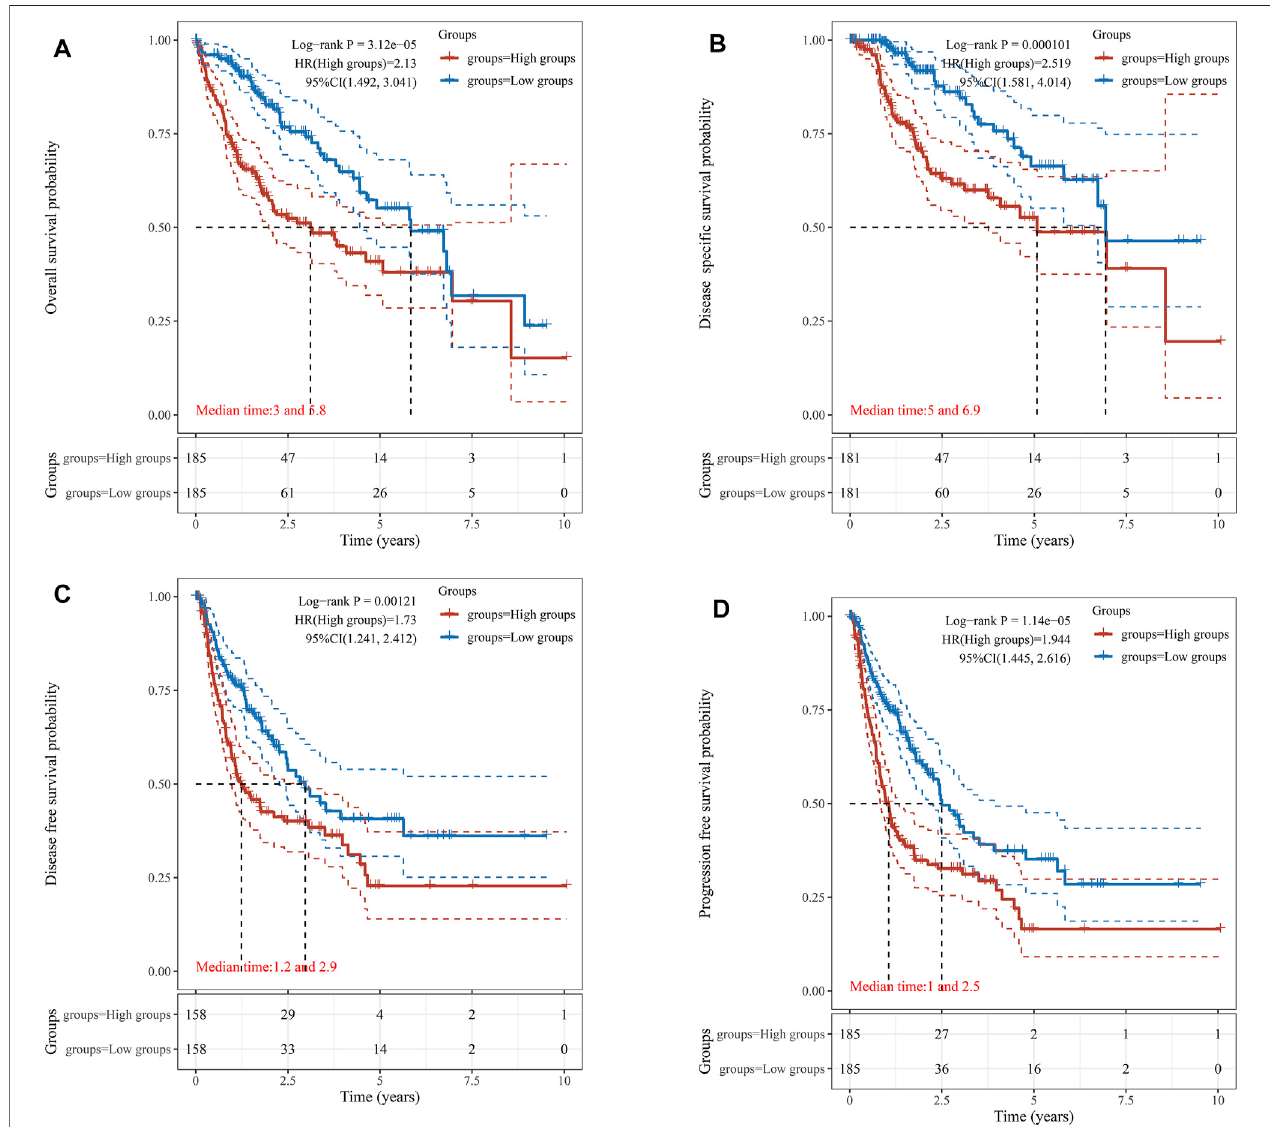
FIGURE 2 | Association of KIFC1 expression with patient survival curve. (A) Overall survival curve. (B) Disease-speci fi c survival. (C) Disease-free survival. (D) Progression-free survival.